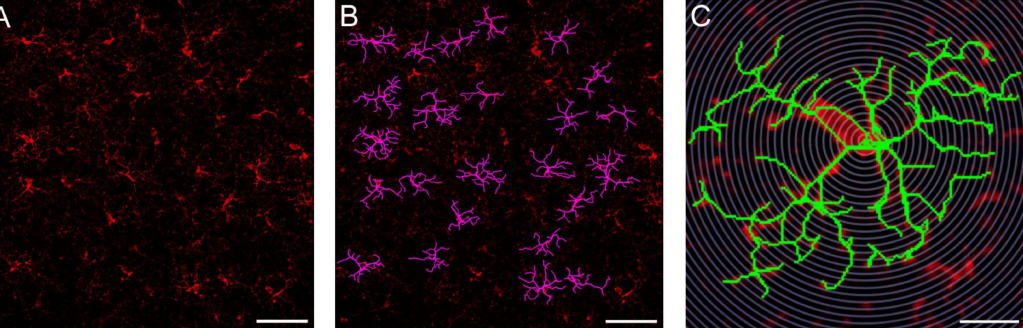
Figure 6. Microglia cells segmentation and Sholl analysis. ( A ) Confocal image of microglia IBA-1 posi- tive cells. Scale bar = 50 µ m. ( B ) Examples of manually segmented microglial cells. Scale bar = 50 µ m. ( C ) Sholl analysis of a representative microglial cell. Scale bar = 5 µ